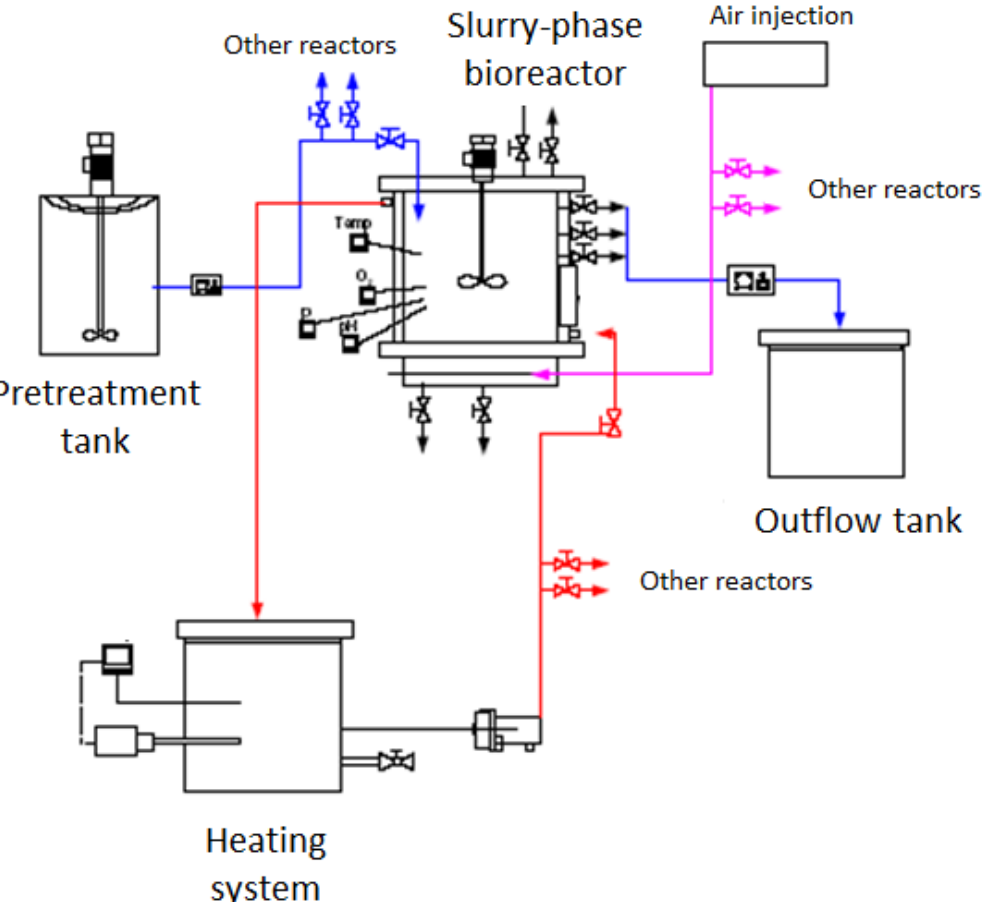
Figure 1. The 40-l slurry bioreactor and auxiliary devices.